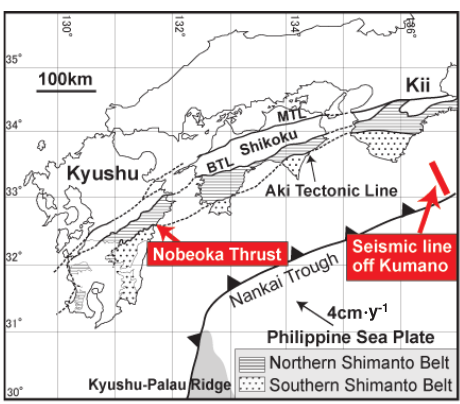
Figure 1. Locations of the Nobeoka OOST and the seismic line off Kumano.